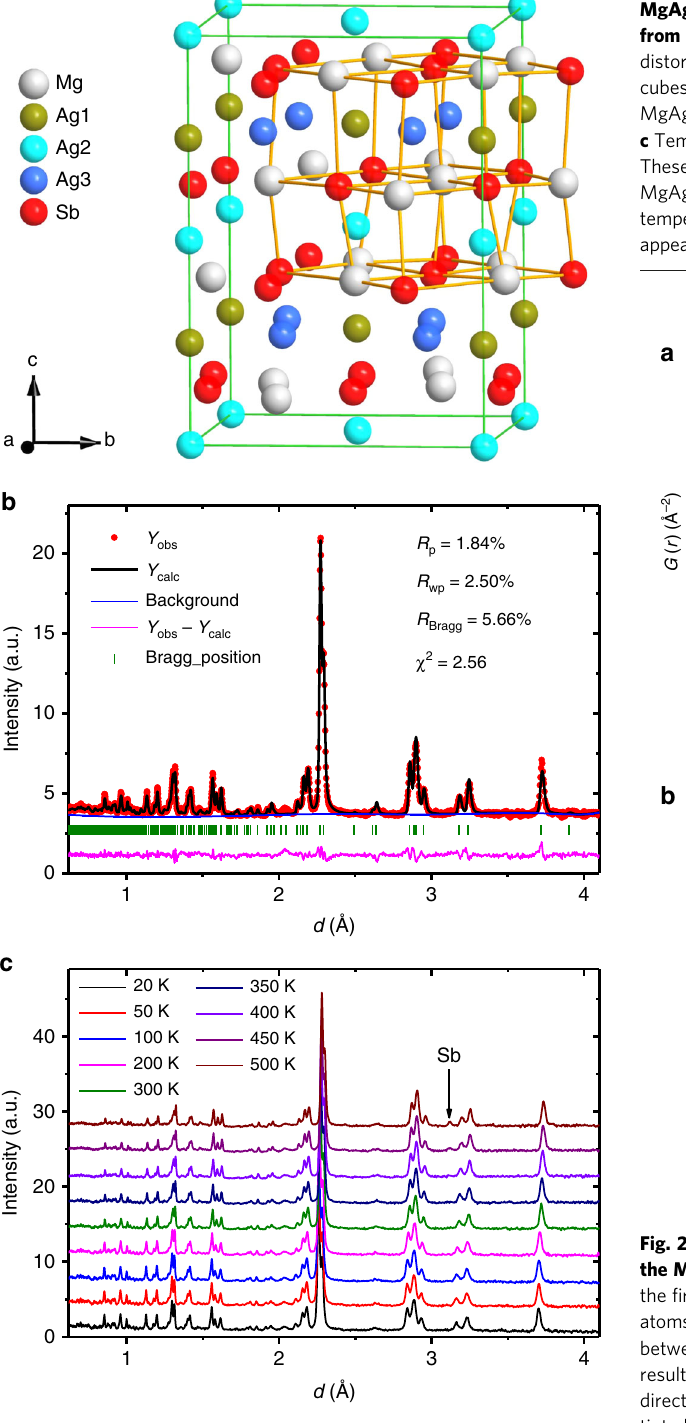
novel double-mushroom scattering pattern arising from the QBZ center is observed in Fig. 3a. To examine the acoustic nature of the low-energy vibration modes, we using the resonant ultrasound spectrometer measured sound velocities, with V T = 1102 m/s and V L = 3708 m/s 27 , calculated the dispersions that are the magenta and green solid lines arising from the QBZ center in Fig. 3a for the transverse and longitudinal acoustic modes, respectively. The E -cut data at 2.0, 2.5, and 3.0 meV are shown in Fig. 3d. The green and magenta arrows indicate the longitudinal and transverse phonon peak positions, respectively, which were calculated using the sound